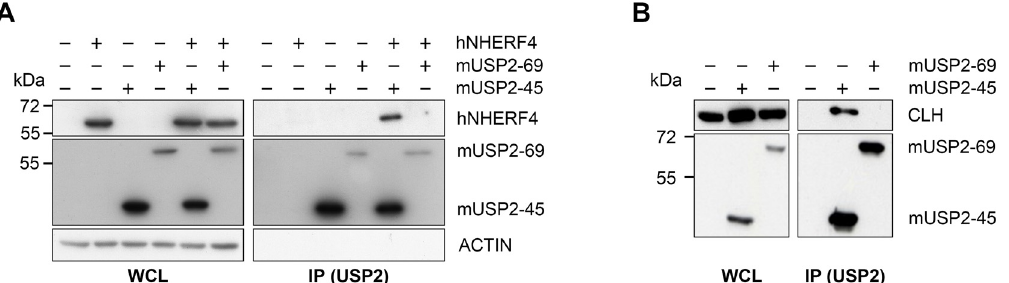
Fig 4. USP2-45 interacts with NHERF4 and endogenous Clathrin Heavy Chain (CLH) in HEK293 cells. HEK293 cells were transfected as indicated and S-tagged USP2-45 or USP2-69 were precipitated with biotinylated S-Protein and Streptavidin-Sepharose beads. Whole cell lysate (left panel, WCL) and precipitation fraction (right panel, IP S-Protein (USP2)) were analysed by SDS-PAGE and western blotting with S-protein HRP (USP2), anti-NHERF4 ( A ) and anti-CLH ( B ) antibodies. Data are western blots from one representative experiment out of three.